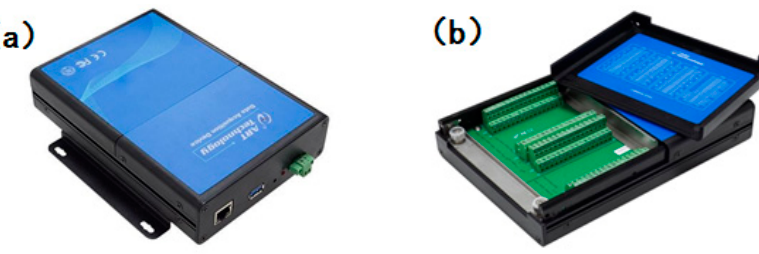
Figure 10. A physical figure of the USB5630 data acquisition card, ( a ) outside and ( b ) inside.